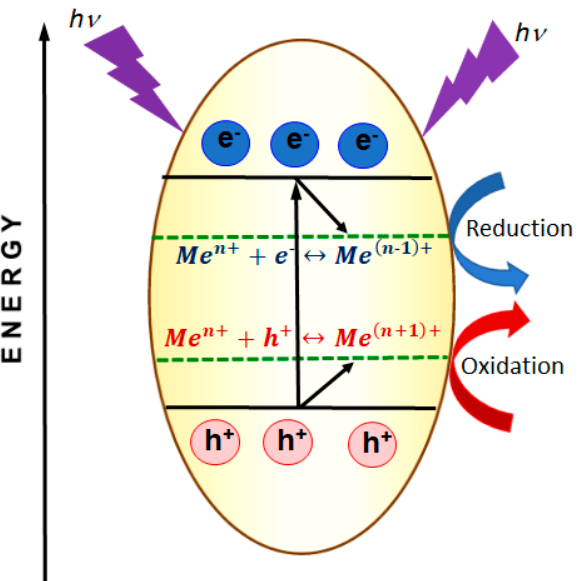
Figure 3. A schematic diagram of the e ff ects of CeO 2 doping with metals (Me) on enhanced photogenerated hole (h + ) / photoexcited electron (e − ) pair separation. CeO 2 doped with metals and non-metals was successfully applied as a photocatalyst in the degradation of di ff erent pollutants which are present in wastewater (Table